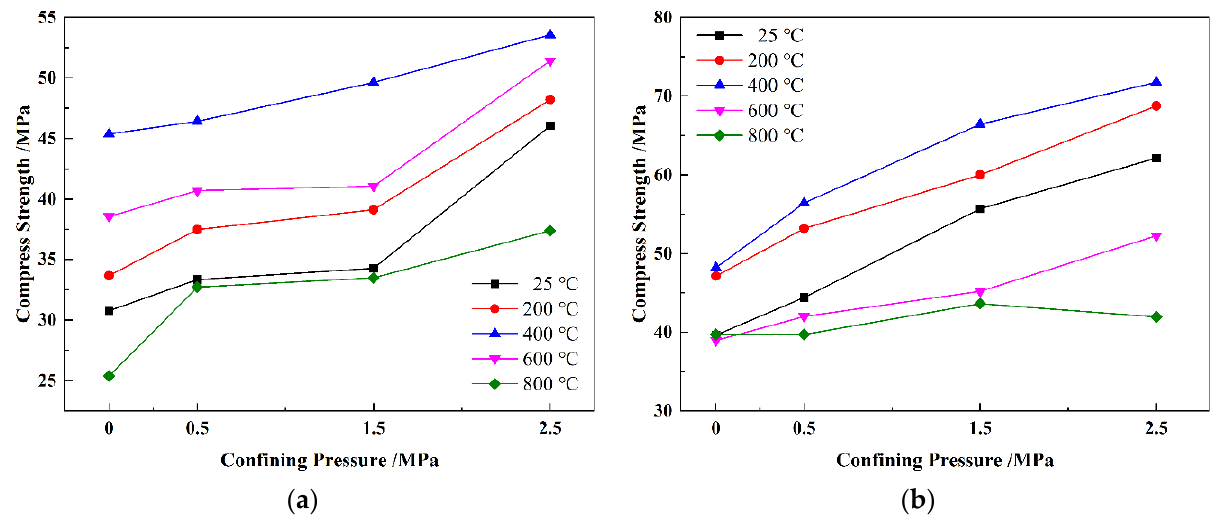
Figure 11. Dynamic compressive strength of limestone under different confining pressures after high-temperature treatment. ( a ) Impact velocity = 5.3 m/s; ( b ) impact velocity = 8.6 m/s.